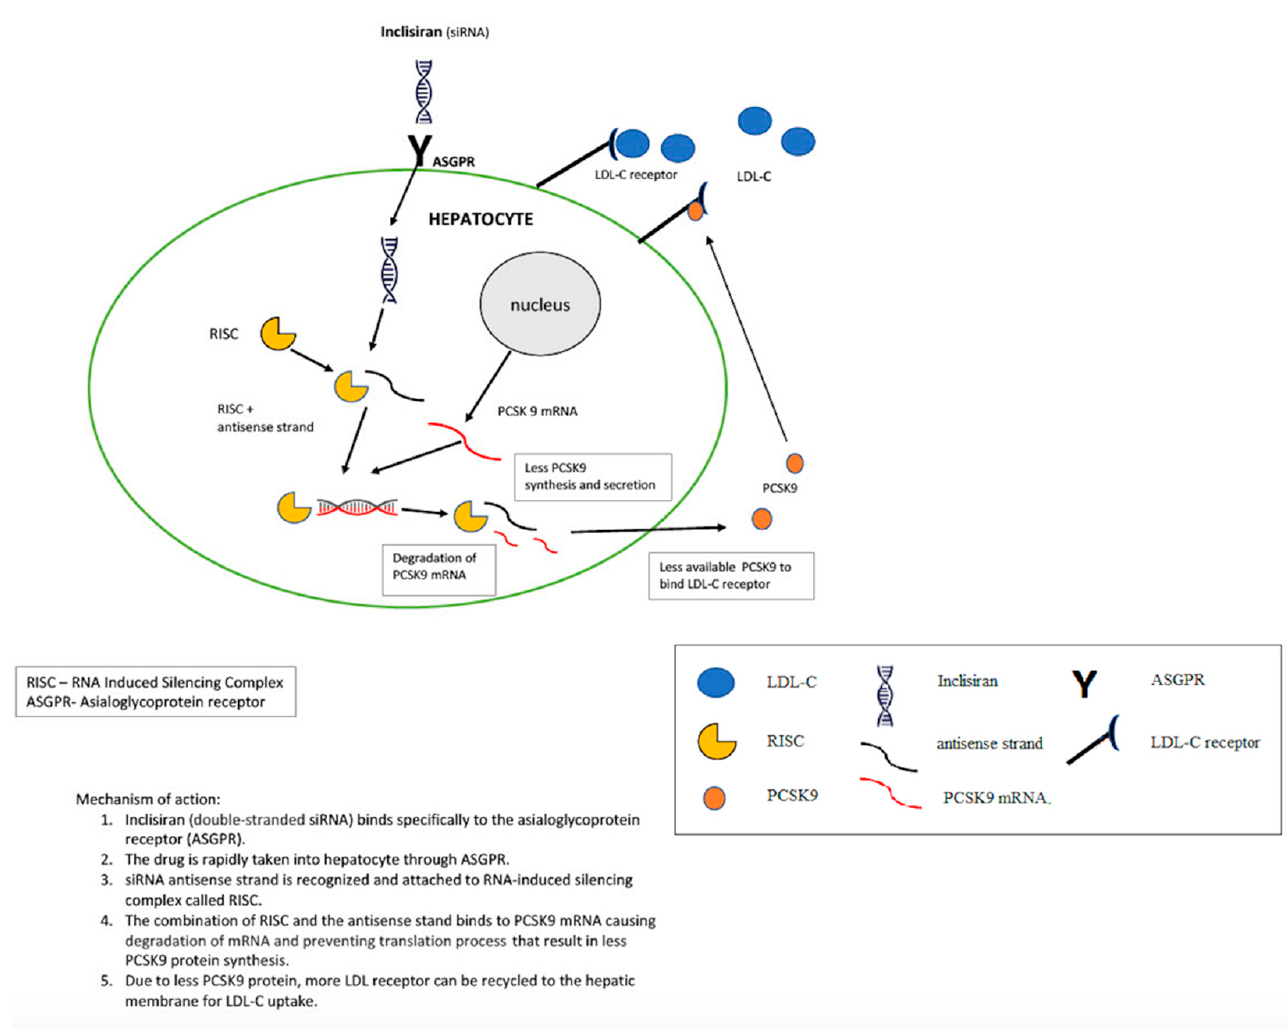
Figure 2. Mechanism of action of inclisiran.